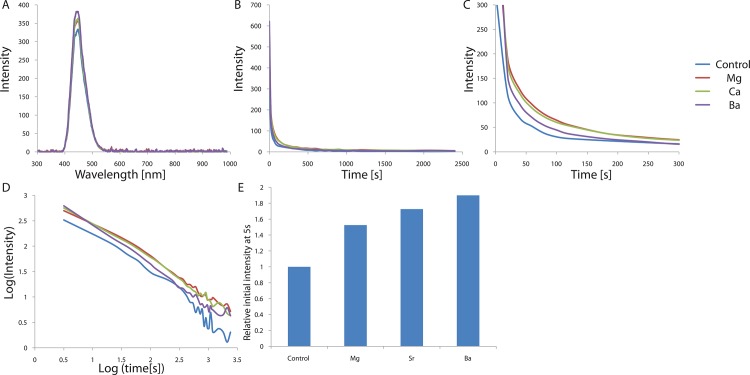
(A) Emission spectrum of CaAl2O4:Eu2+, Nd3+ crystals depending on alkali earth metal ion doping. (B) Decay curves depending on alkali earth metal ion doping. (C) Magnified views of the graph in (B). (D) Decay curves in log scale depending on alkali earth metal ion doping. (E) Relative initial intensity measured at 5s (relative values where the value of control sample is 1.0) depending on alkali earth metal ion doping.